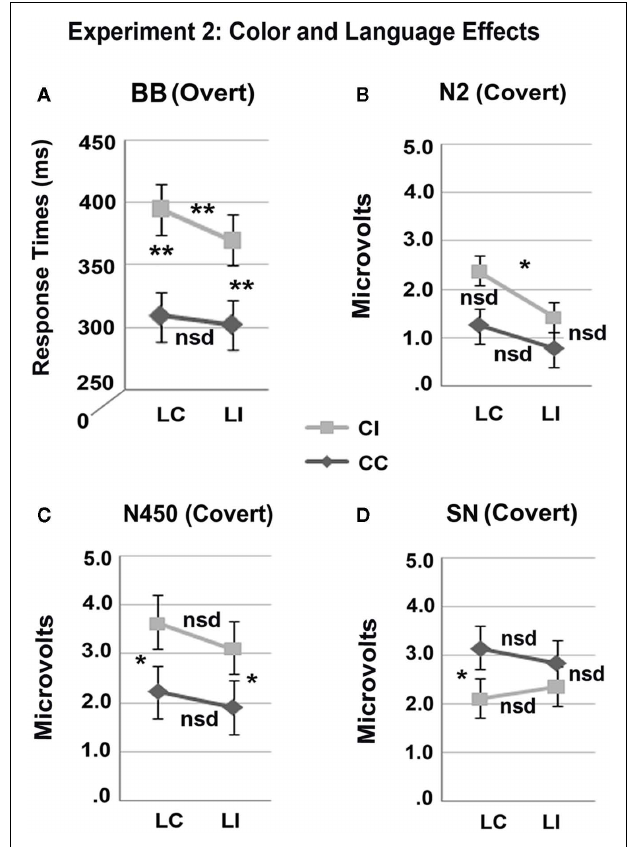
FIGURE 4 |The interaction between color and language in the overt behavioral results (mean response times) and all three times windows of the covert ERP results (mean amplitude). Note that interactions were observed only for data in (A,D) ; only main effects of language congruence and color congruence were observed in data from (B) the difference between language congruent and incongruent stimuli trended at p = 0.122) and (C) , respectively: ** p ≤ 0.001; * p ≤ 0.050; nsd, non-significant